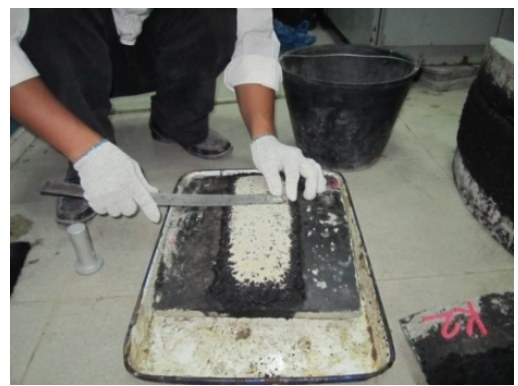
( b ) tack coat and arc-shaped micro-surfacing specimen. tack coat and arc-shaped micro-surfacing specimen.